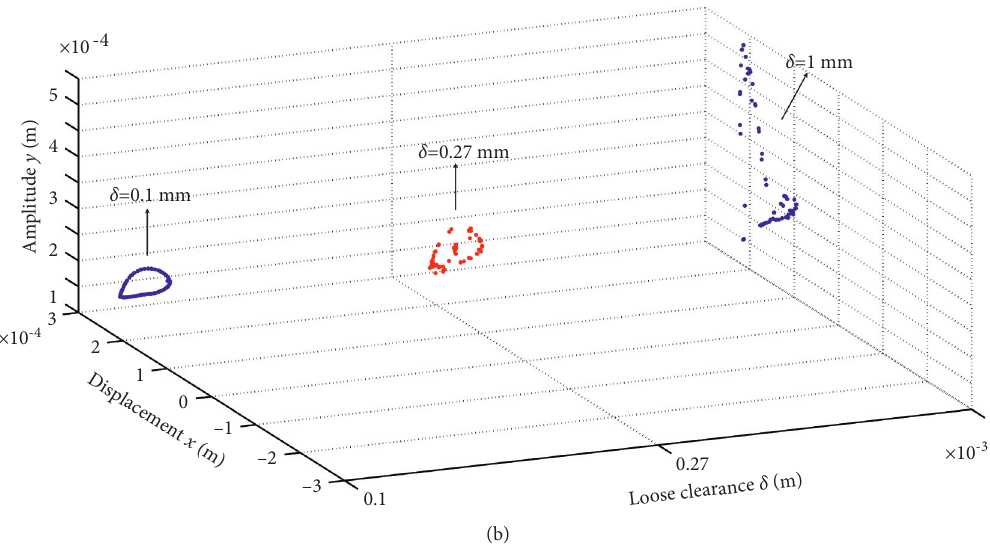
Figure 15: Rotor orbits and Poincar´e maps of the right journal with the change of the loose clearance. (a) Rotor orbits. (b) Poincar´e maps. ×10 -4 -30.54